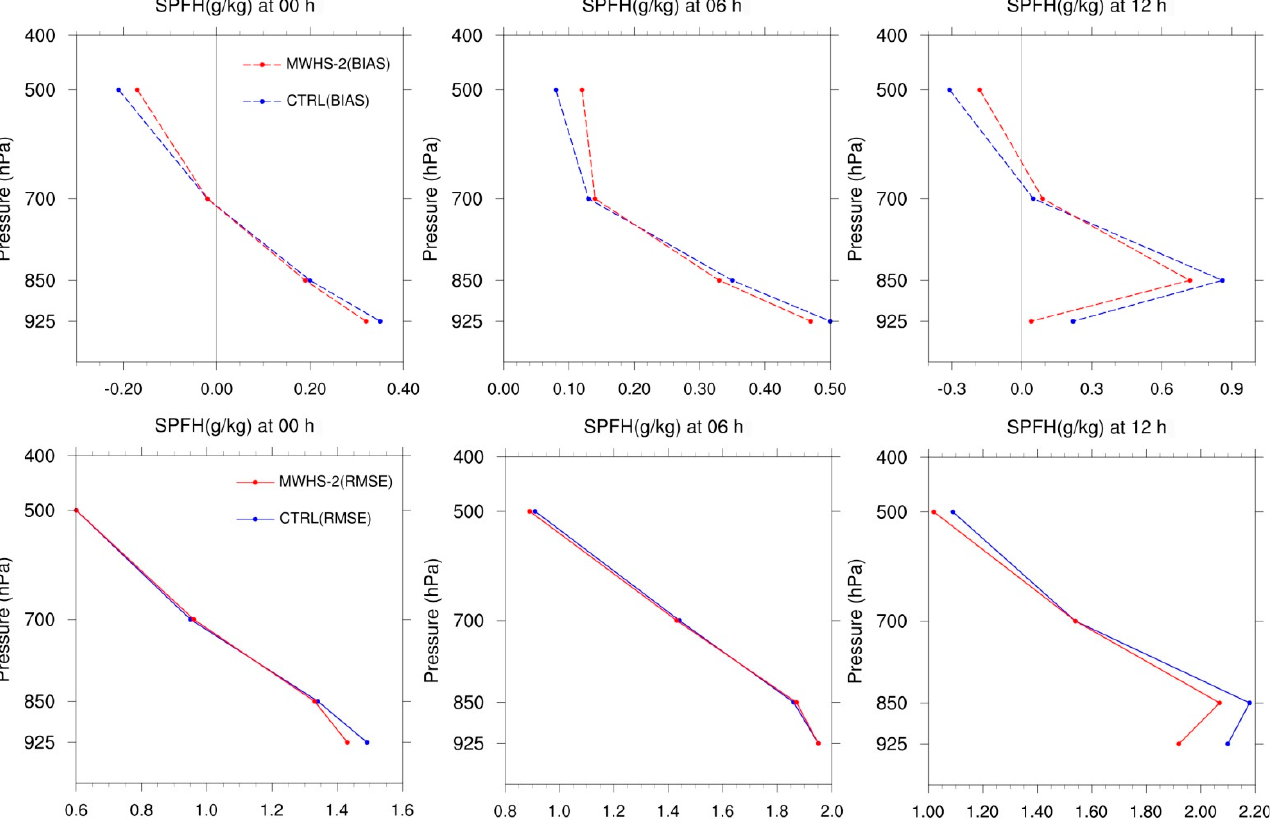
Figure 12. Mean bias (dash line in the first row) and RMSE (solid line in the second row) of hu- midity at 00 h, 06 h and 12 h of the forecasts starting at 03 UTC, 06 UTC, 12 UTC and 18 UTC against observations.